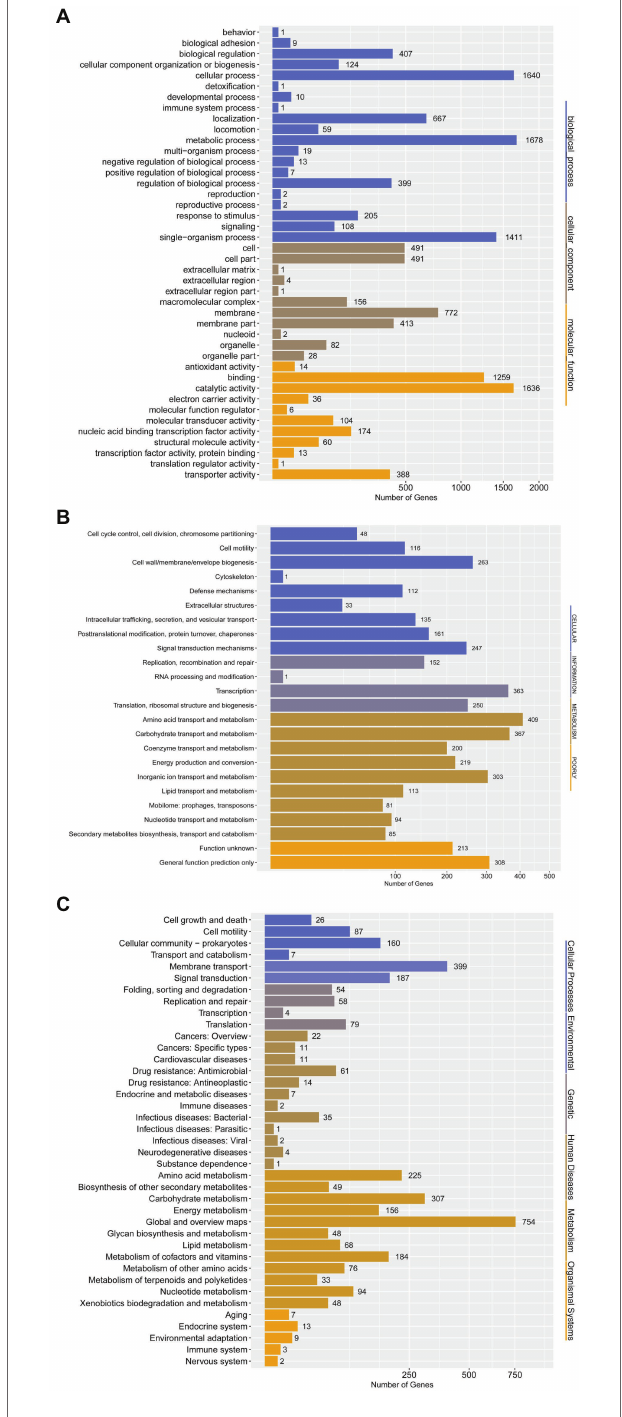
FIGURE 5 | Gene annotation by GO, COG, and KEGG for P. aroidearum L6. (A) GO function classification of genes in L6. GO analysis was performed for three main categories: cellular components, molecular function, and biological processes. (B) COG function classification of genes in L6, grouped into four main parts: metabolism, cellular processes, information, and poorly. (C) The KEGG pathway classification of genes in L6 contains six groups: cellular processes, environmental, genetic, human diseases, metabolism, and organismal